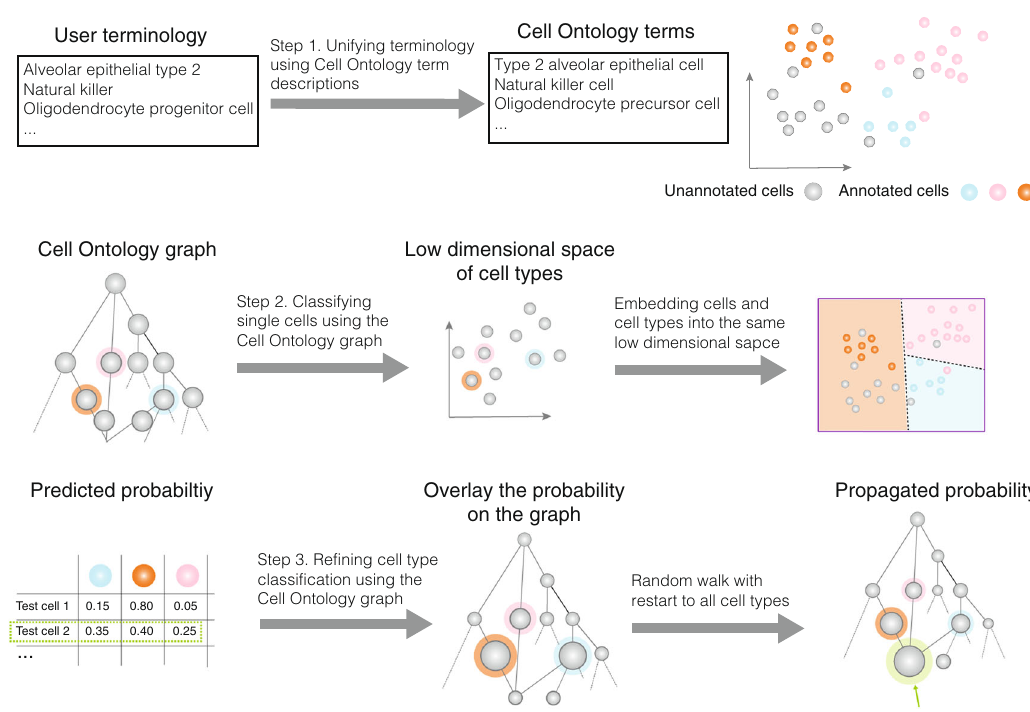
Fig. 1 OnClass overview. OnClass fi rst maps user terminology to Cell Ontology terms based on the text embedding similarity. It then embeds cell ontology terms into a low-dimensional space using the Cell Ontology graph. Single-cell transcriptomes are then projected into the same low-dimensional space using a nonlinear transformation. Finally, OnClass re fi nes the annotation of each cell by fi rst overlaying con fi dence scores on the Cell Ontology graph and then propagating these scores using random walk with